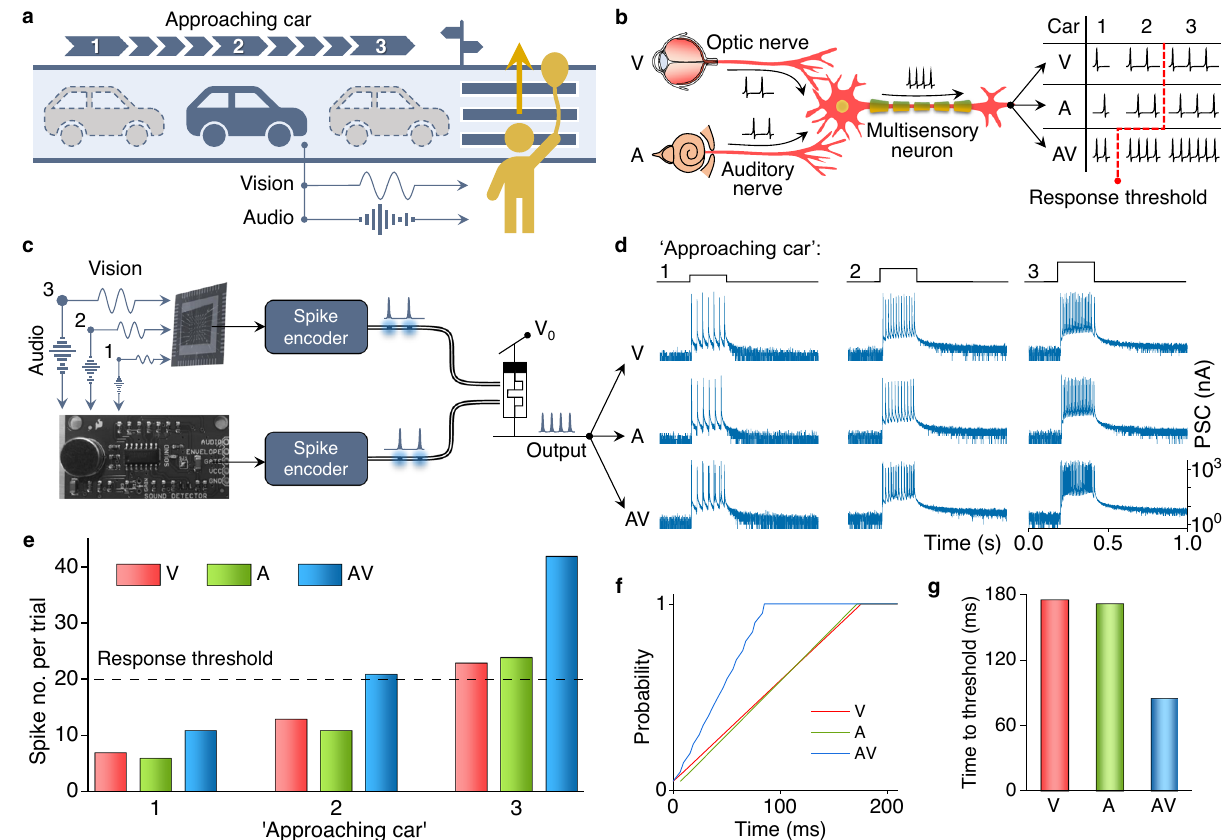
Fig. 3 Bioinspired multisensory neuron with crossmodal integration. a Simulated situation of a person crossing a road. The person sees and hears an approaching car. The strengths of the auditory and visual input scale with the car ’ s position, as labeled by numbers 1, 2, and 3. b Schematic of a biological multisensory neuron in the superior colliculus. The red dashed line indicates the response threshold of the neuron under visual (V), auditory (A), and combined auditory-visual (AV) stimulation. c Arti fi cial multisensory neuron integrating visual and auditory sensory neurons. Three signal levels, weak (1), medium (2), and strong (3), corresponding to the positions of the car, are considered. d PSC signal of the photomemristor with rate-coded sensory information during V, A, and AV stimulation. Three signal levels are tested. The sensory input duration is 0.2 s. e Number of PSC spikes during each trial in ( d ). We assume a neuronal response threshold of 20 spikes (dashed line). f , g Response probability (one equals 20 PSC spikes) and latency to reach the response threshold for strong inputs